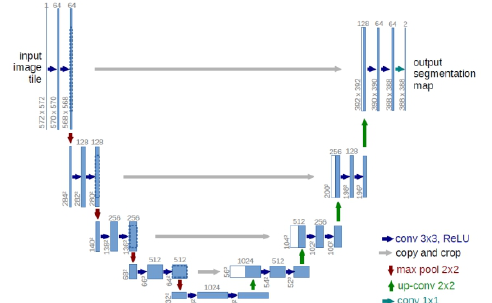
Figure 7. Unet Model(Ronneberger,